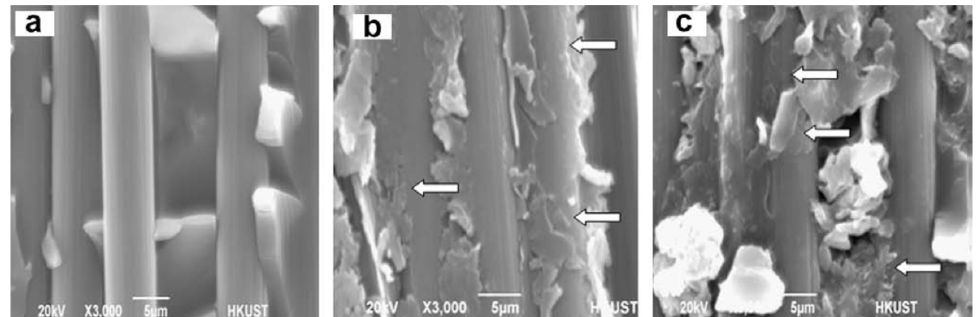
Figure 15. Photographs of fracture surfaces after an interlaminar shear test for CFRPs composites with different clay contents: ( a ) 0 wt %; ( b ) 3 wt % and ( c ) 5 wt % [132].